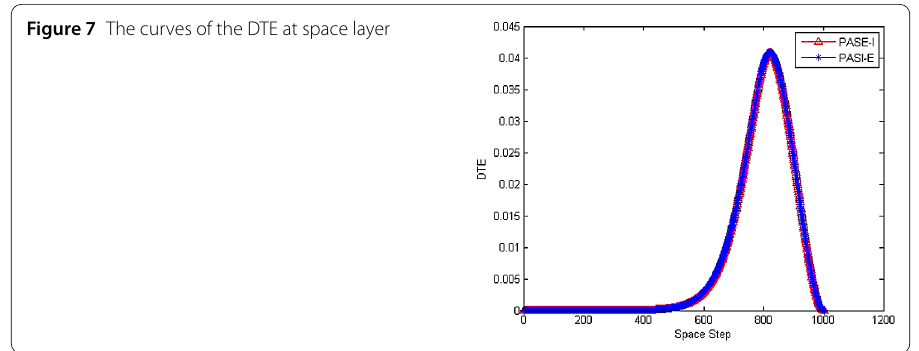
Figure 7 The curves of the DTE at space layer